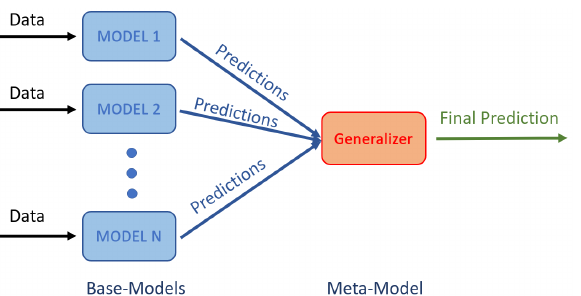
Figure 7. Architecture of the stacking ensemble: Several base classification models are applied to the same data and the meta model learns how to best combine the predictions from the different base